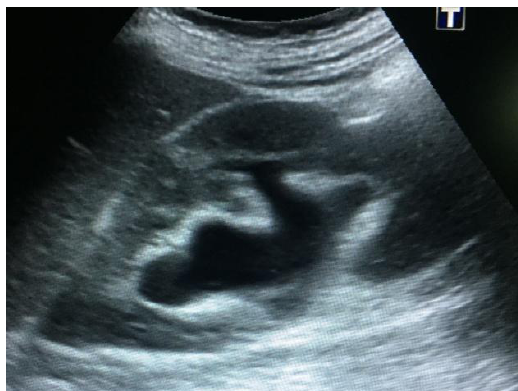
Figure 1: USS of the abdomen showing right sided hydronephrosis